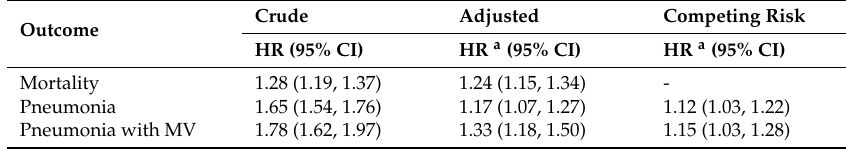
Table 2. Incidences and risks of pneumonia, pneumonia with mechanical ventilator (MV), and all-cause mortality among COPD patients with and without AF after propensity score matching. Crude Adjusted Competing Risk Outcome